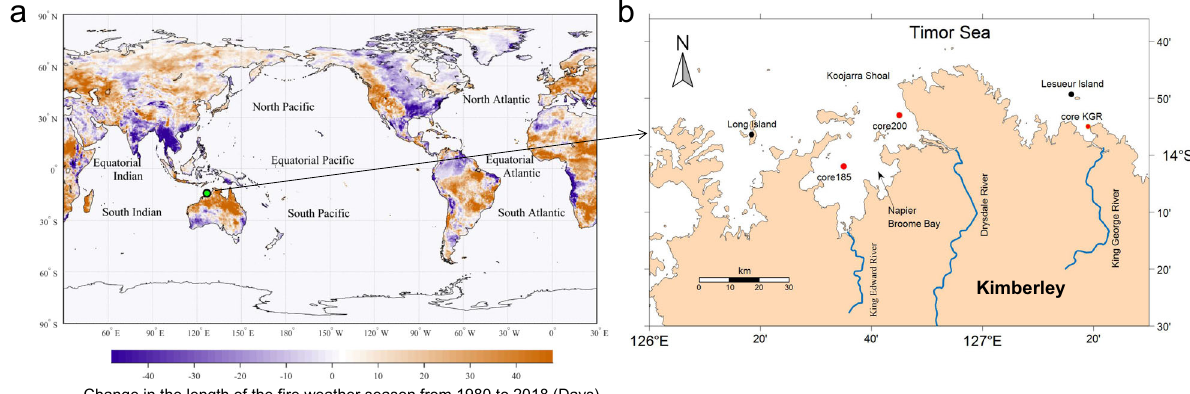
Fig. 1 Maps showing changes in the length of the fi re weather season on a global scale and sampling location. a Map showing the change in the length of the fi re weather season between 1980 and 2018 (data from the ERA5 data set 13,14 ; the green circle indicates the Kimberley coast, a fi re-prone region in northern Australia). b Sampling sites of core 185, core 200, and core KGR (red dots) in the Kimberley